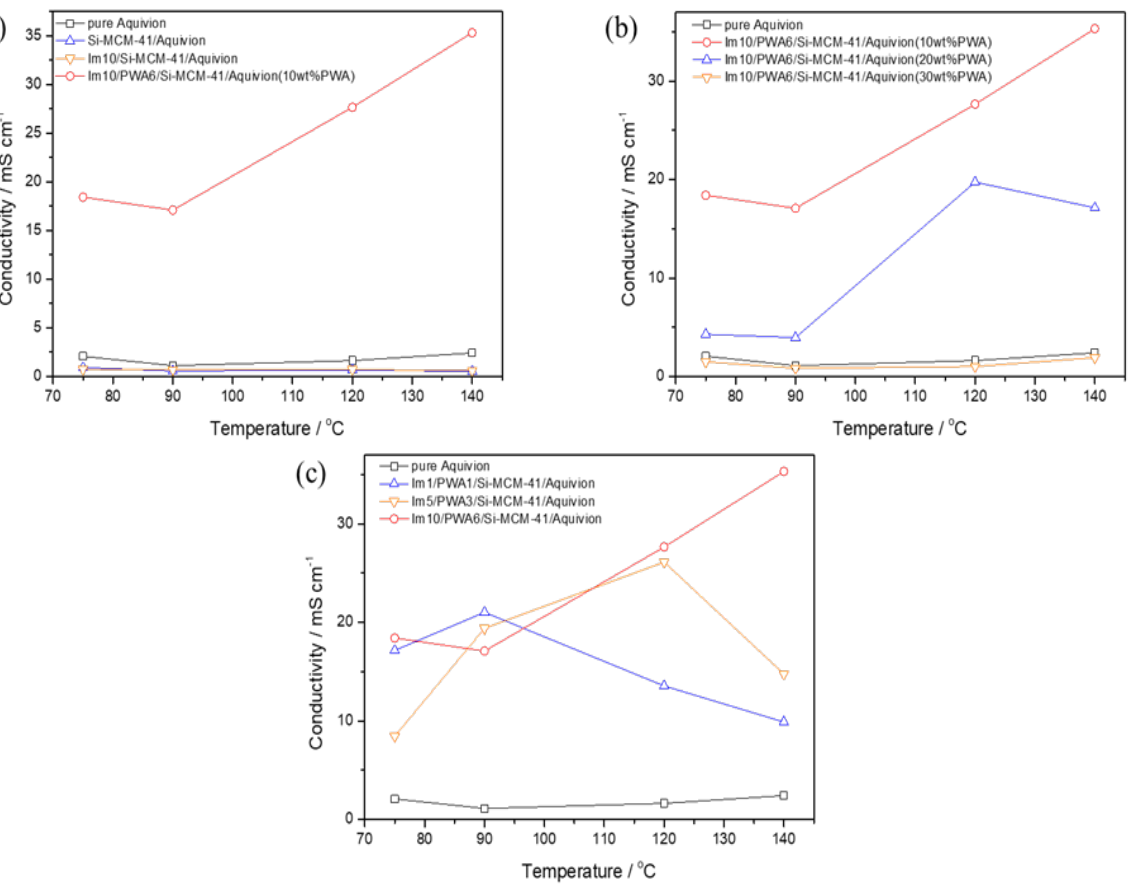
Figure 6. Proton conductivity at different temperatures and 10% RH of ( a ) Aquivion™, Si-MCM-41, Im10/Si-MCM-41, Im10/PWA6/Si-MCM-41 composite membranes, ( b ) Im10/PWA6/Si-MCM-41 composite membranes changing the content of Imi/PWA/MCM-41, and ( c ) 10 wt% Im(x)/PWA(y)/Si-MCM-41 composite membranes.